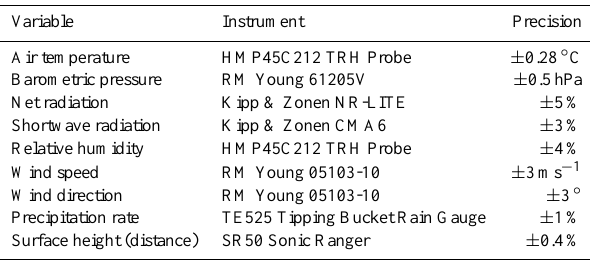
Table 1. Instrumentation deployed at AWS locations on North and South Glaciers. Manufacturer documentation is the source of in- strument precision. Precipitation for South Glacier was measured 500m from AWS.